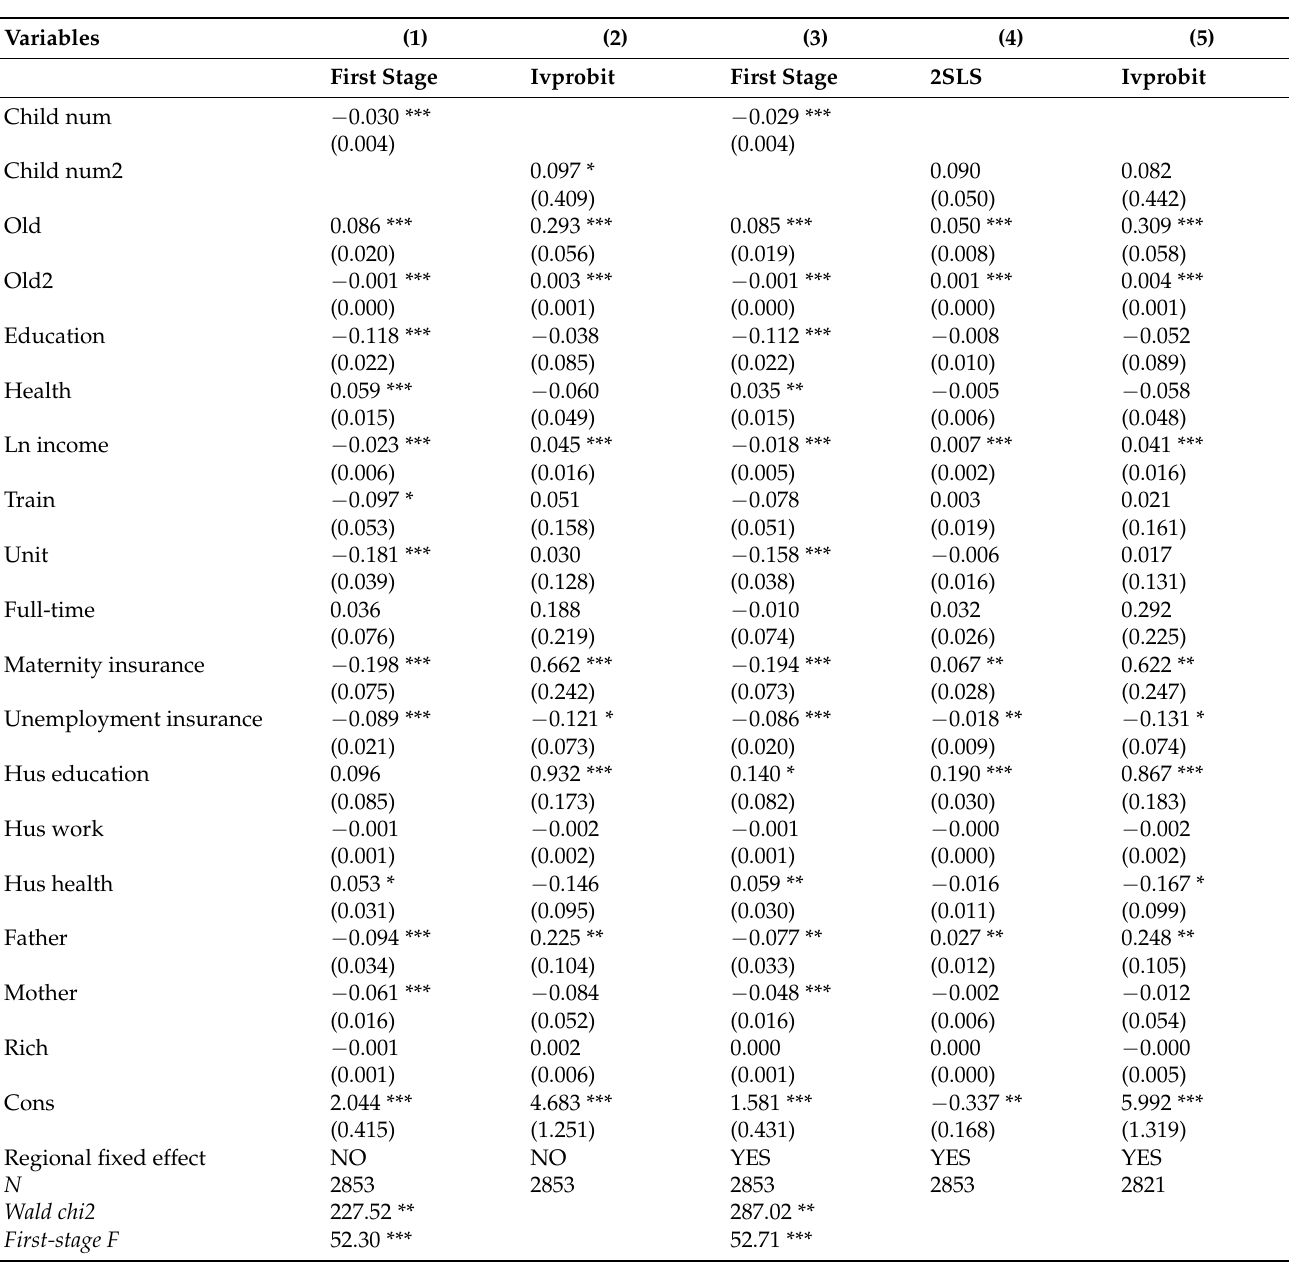
Table 7. Endogeneity